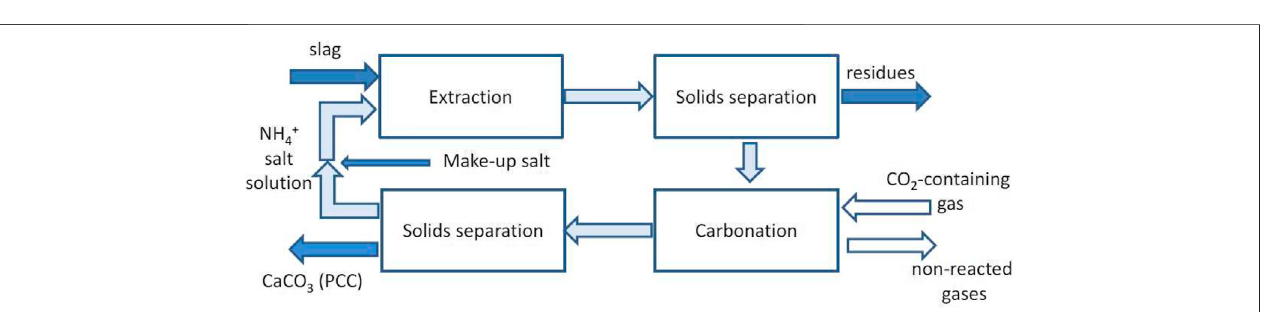
FIGURE 2 | Flow diagram of the Slag2PCC concept for PCC production from steel-making slags. Reproduced with permission from Zevenhoven et al. (2019).